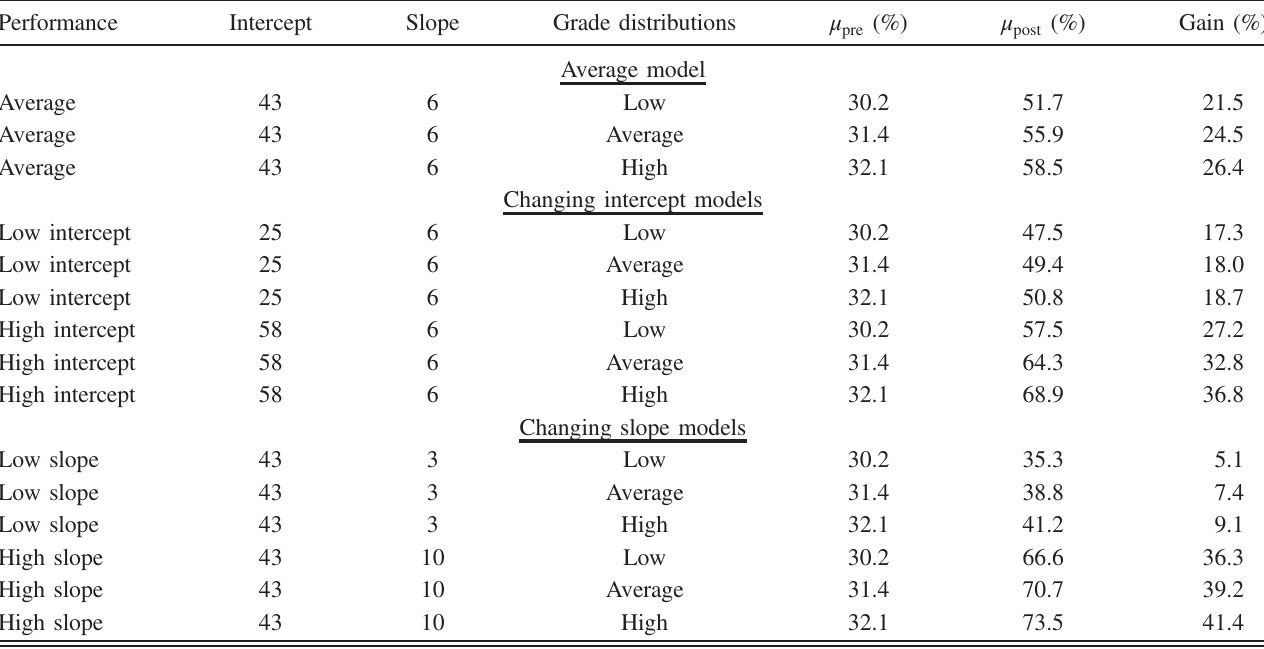
TABLE IV. Descriptive statistics for the 15 simulated courses average true pretest and post-test scores and gains.